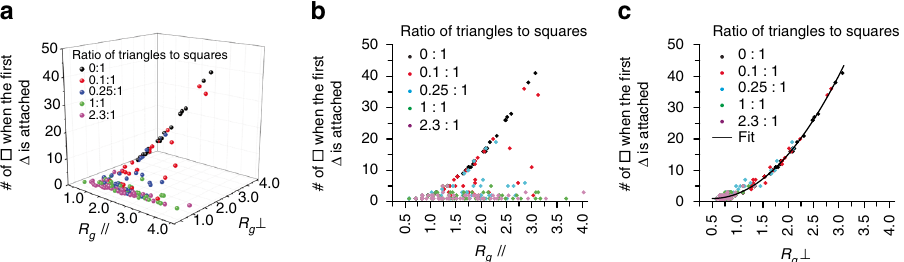
Fig. 5 Analysis of simulated single-particle growth trajectories. a 3D plot showing that phason strain is highly dependent on the time at which the fi rst triangle is added to the growing particle. b , c 2D projections of the 3D plot in a . The data in c is fi tted using equation Na 2 = AR g ⊥ 2 + aBR g ⊥ + a 2 C , where a = 1 is the edge length of a square tile, N is the number of tiles, and A , B , and C are fi tting parameters. This is consistent with the theoretical relationship between the area and the radius of gyration, R g , of a 2D square packing pattern (Supplementary